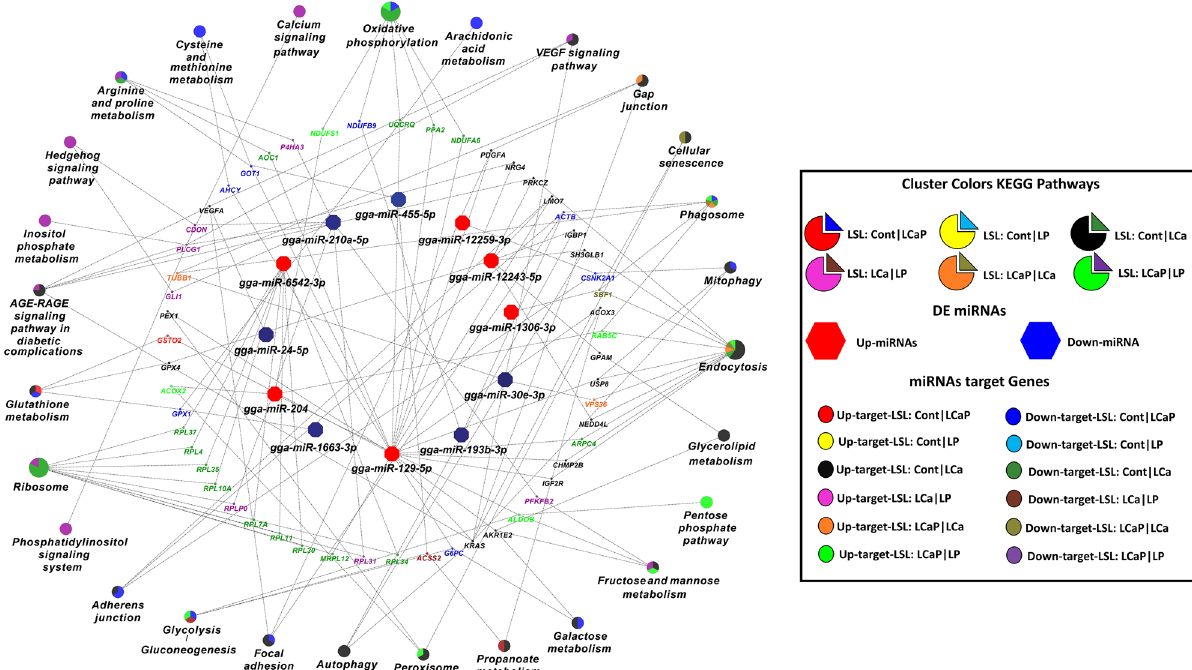
Figure 7. KEGG pathways enrichment analysis of differentially expressed (DE) known miRNAs and their DE target genes from pairwise comparisons between diet groups within LSL strain. KEGG pathways enrichment analysis was performed by ClueGO (version 2.5.1) and Cluepedia (version 1.5.7) plugin in Cytoscape (version.3.6.1) environment. ClueGO generated functionally clustered KEGG annotation network of DE miRNAs and their DE target genes. P value was calculated by right-sided hypergeometric tests and Benjamin– Hochberg adjustment was used for multiple test correction. KEGG pathways with a P < 0.05 were considered